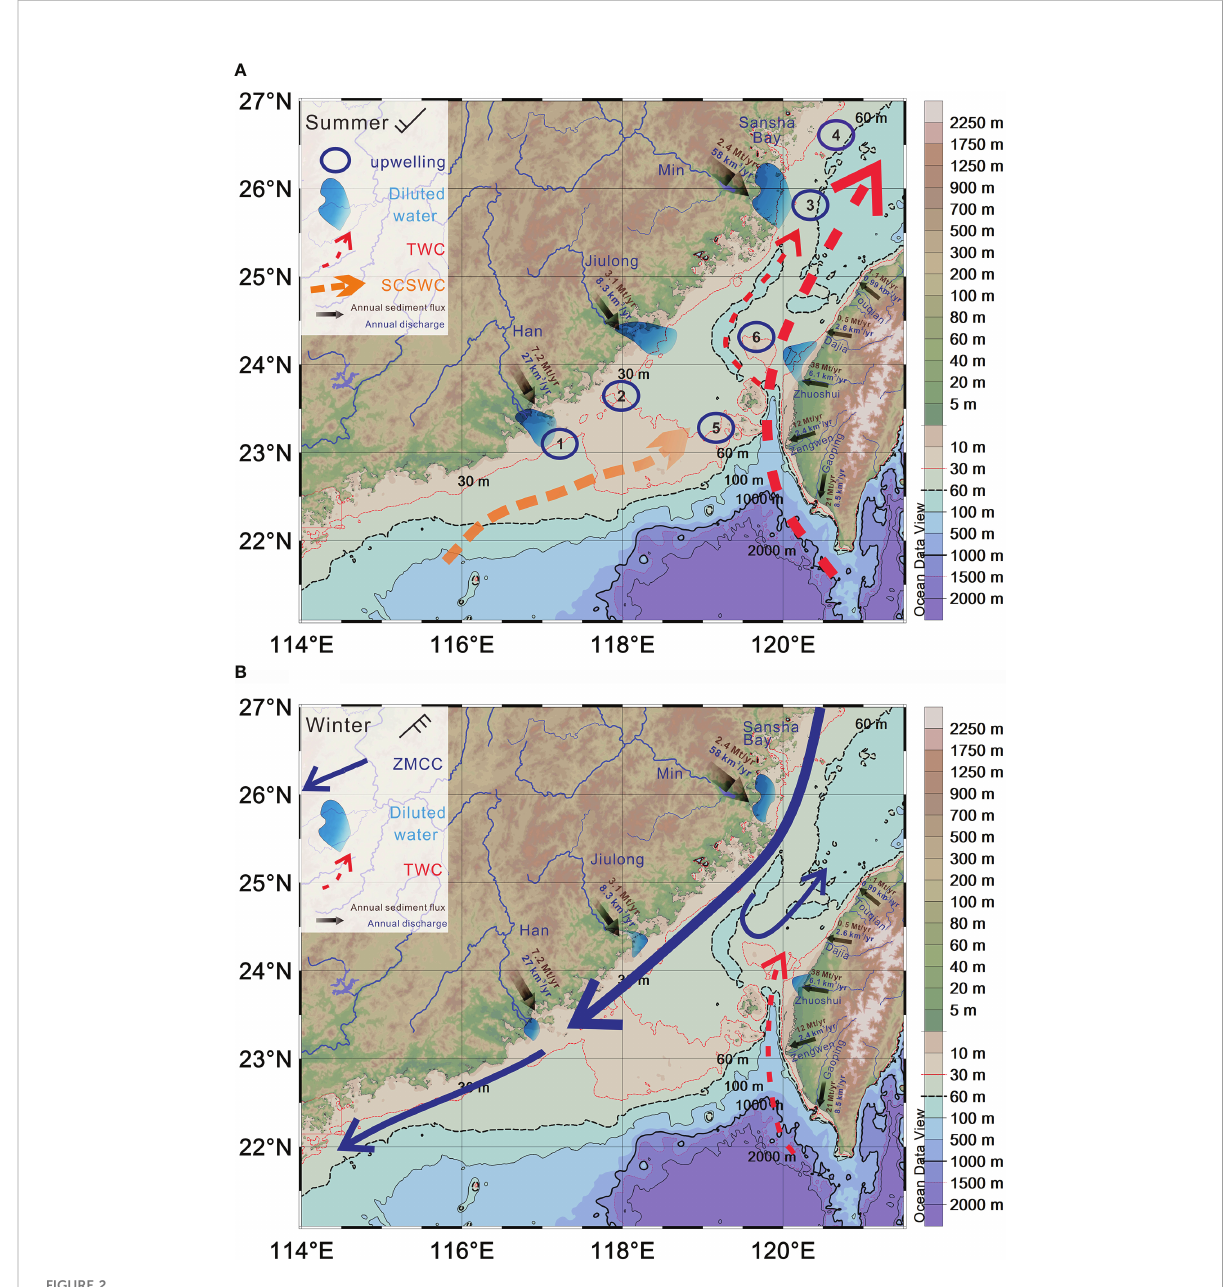
FIGURE 2 Seasonal circulation and its impact on sediment dispersion within the TS modi fi ed from Xu et al. (2009). Upwelling zones are de fi ned by Liu et al. (2019). (A) In summer, small mountainous rivers from Taiwan discharge most of its annual sediment, the fi ner fraction being winnowed and transported northward by the energetic TWC and SCSWC. The dispersal of Zhuoshui River plume alternates alongshore controlled by the tide (Lee et al., 2016). (B) In winter, the remaining silts and sands mix with Yangtze clays that are transported southward by the ZMCC in winter. Annual discharges and sediment fl uxes for individual rivers refer to Milliman and Farnsworth